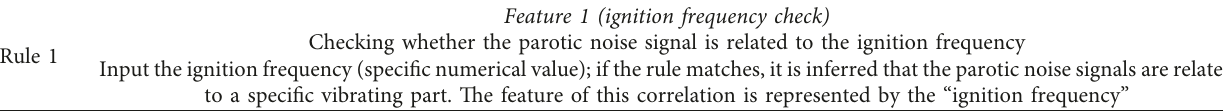
Table 6: Implementation of SWRL rules for feature